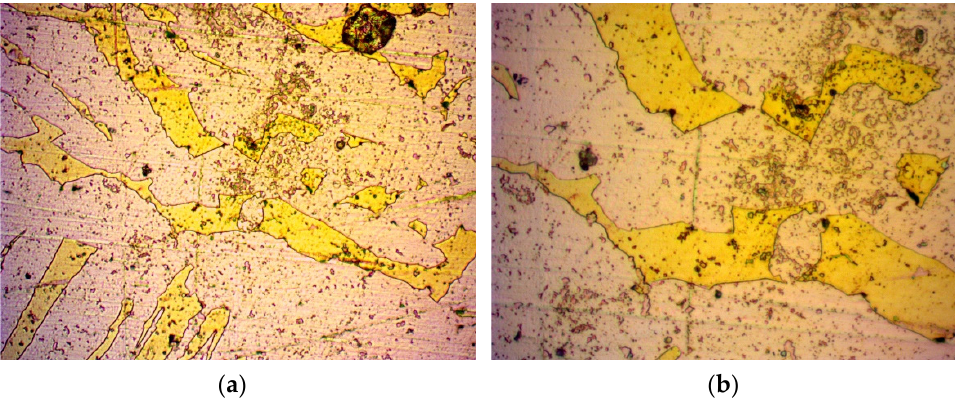
Figure 6. Specimen 4: Image from optical microscope after metallography of work-hardened and annealed brass alloy: ( a ) magnification ×500; ( b ) magnification ×1000.